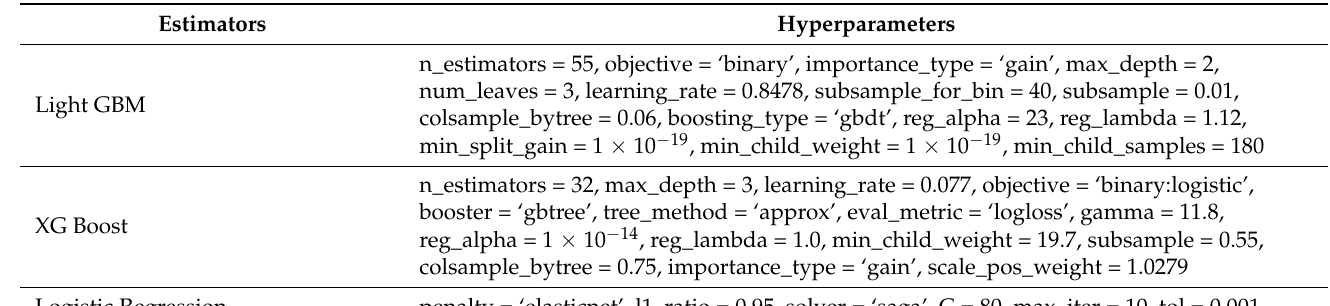
Table 3. Hyperparameters of daily